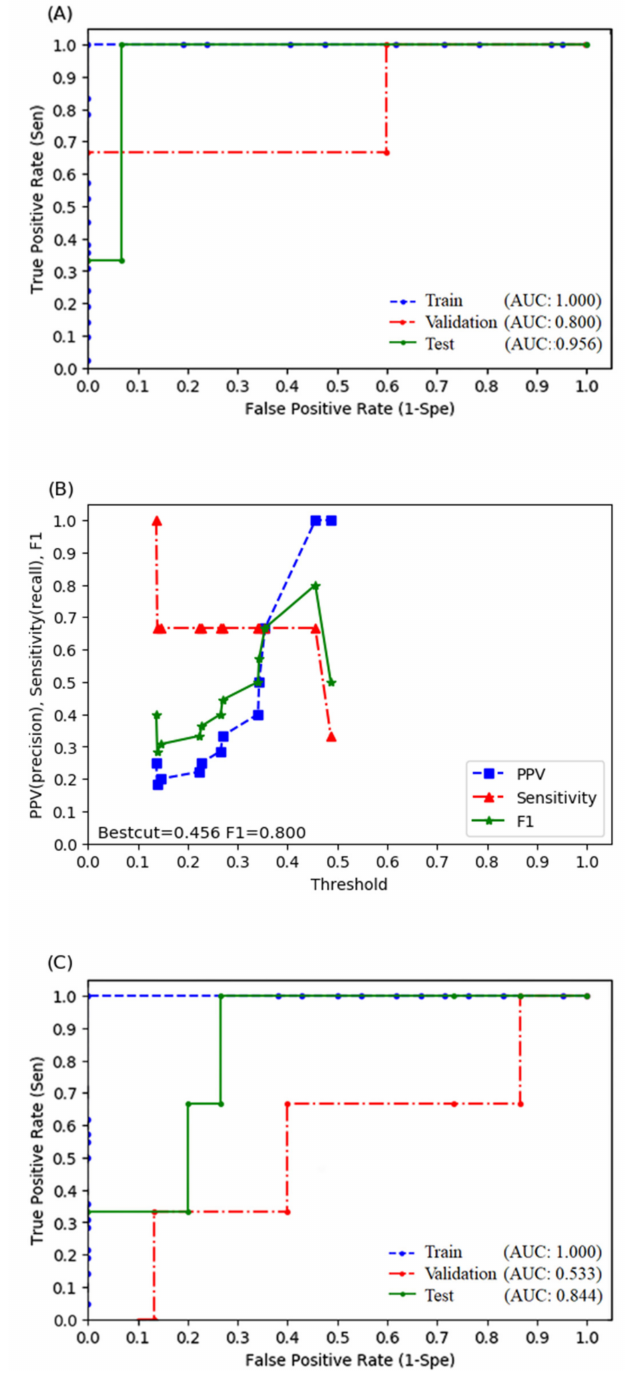
Figure 1. Receiver operating characteristic curve for the random forest (RF) model in training, validation, and test sets with ( A ) or without ( C ) radiomic features. ( B ) The relationship between sensitivity, positive predictive rate, F1 score, and threshold values of the RF model in the validation